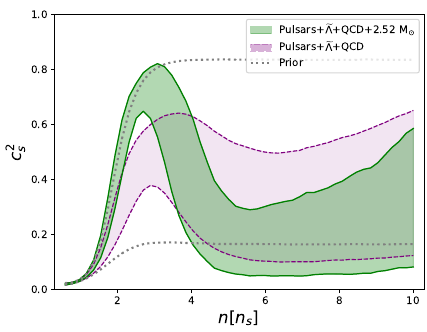
Figure 6. The impact that a discovery of 2.52-solar-mass star would have on the inferred speed of sound. 2.52 solar masses corresponds roughly to the 1 σ upper limit of PSR J0952-0607 and lower limit of the binary merger component of GW190814. The purple band in the background corresponds to the results of [25]; the green band has additional requirement of stable 2.52-solar-mass neutron stars. The interplay between the required sti ff ness at lower densities to support a very massive star combined with the robust QCD constraint would force the equation of state to have a sharp